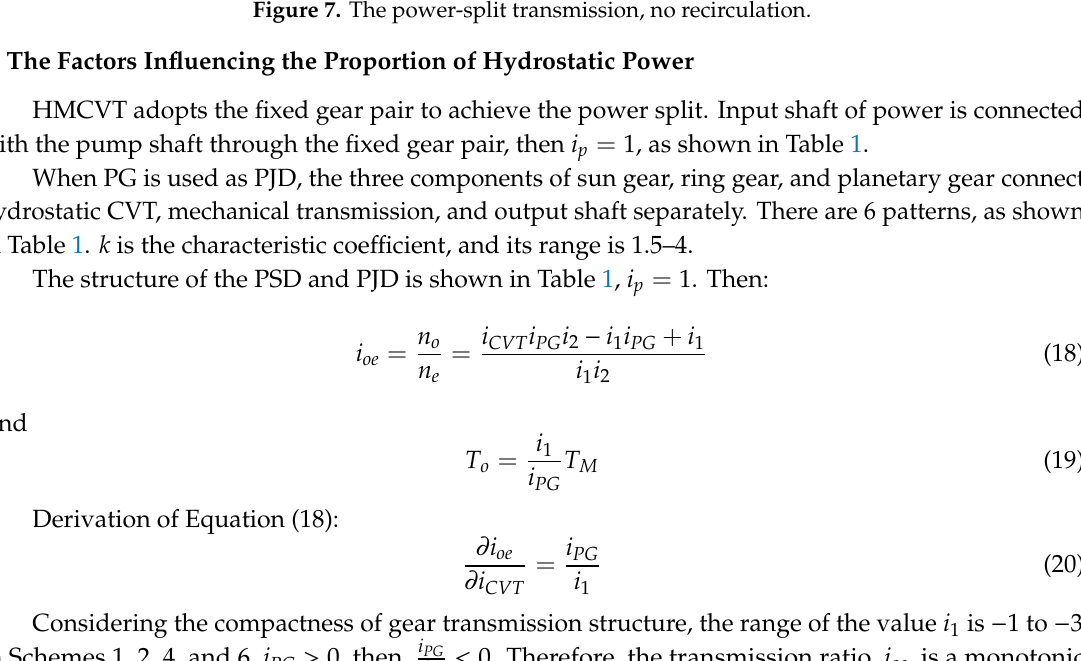
Figure 7. The power-split transmission, no recirculation.